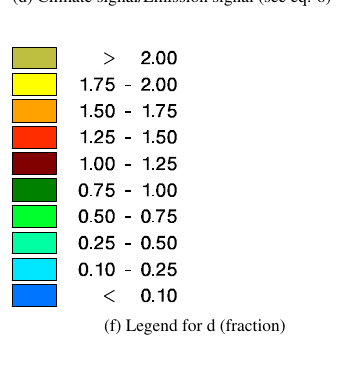
Fig. 8. Total nitrogen (N): as Fig. 4 but for total nitrogen Fig. 8: Total nitrogen (N): As Fig. 4 but for total nitrogen N